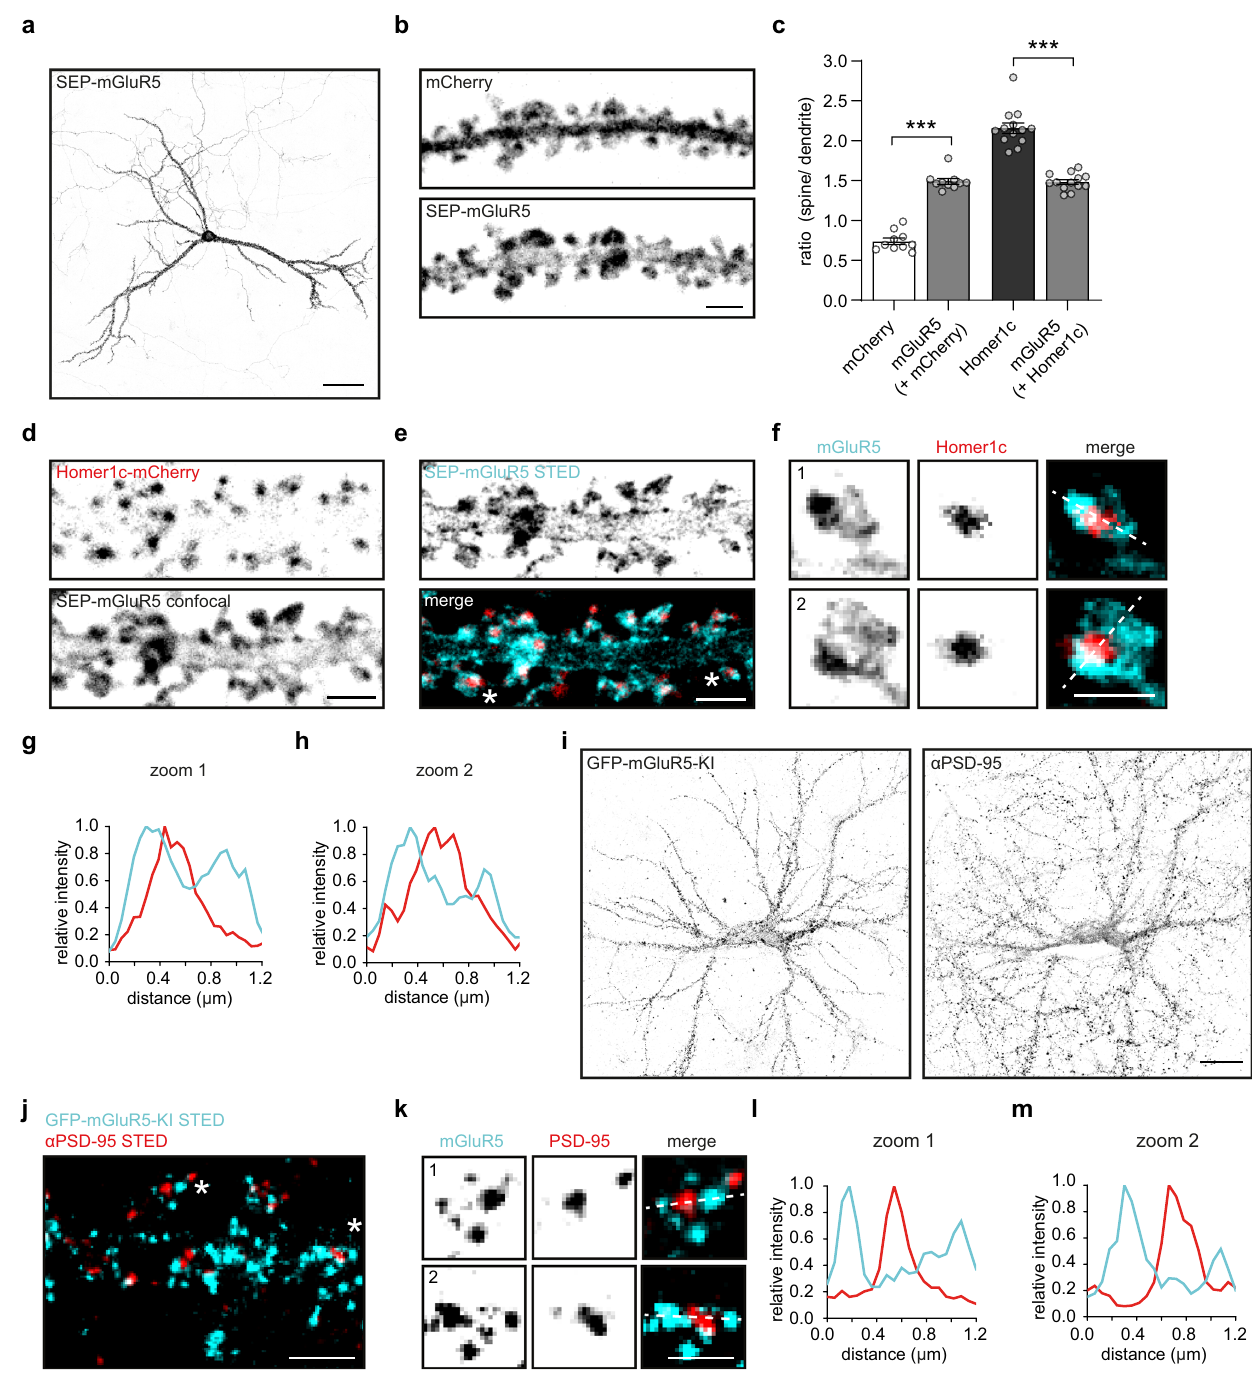
Fig. 1 | mGluR5 is enriched in spines but largely excluded from synapses in hippocampalneurons.a Hippocampalneuron expressingSEP-mGluR5. Scalebar, 50 µ m. b Representative confocal image of dendrite expressing mCherry and SEP- mGluR5, surface-labeled with an anti-GFP nanobody Atto647N. Scale bar, 2 µ m. c Quanti fi cation of the ratio of spine over dendrite intensity of mCherry, surface SEP-mGluR5 co-expressing mCherry ( n =10, p <0.0001; two-sided paired t test), Homer1c-mCherry and surface SEP-mGluR5 co-expressing Homer1c-mCherry ( n =13, p <0.0001; two-sided paired t test). d Representative confocal image of dendrite expressing Homer1c-mCherry and SEP-mGluR5, surface-labeled with an anti-GFP nanobody Atto647N. Scale bar, 2 µ m. e gSTED imaging of SEP-mGluR5 surface-labeledwithananti-GFPnanobodyAtto647N(cyan)andthemergedimage showing the relative localization to confocal-resolved Homer1c-mChery (red), shown in d . Scale bar, 2 µ m. This experiment was replicated in cultures from more